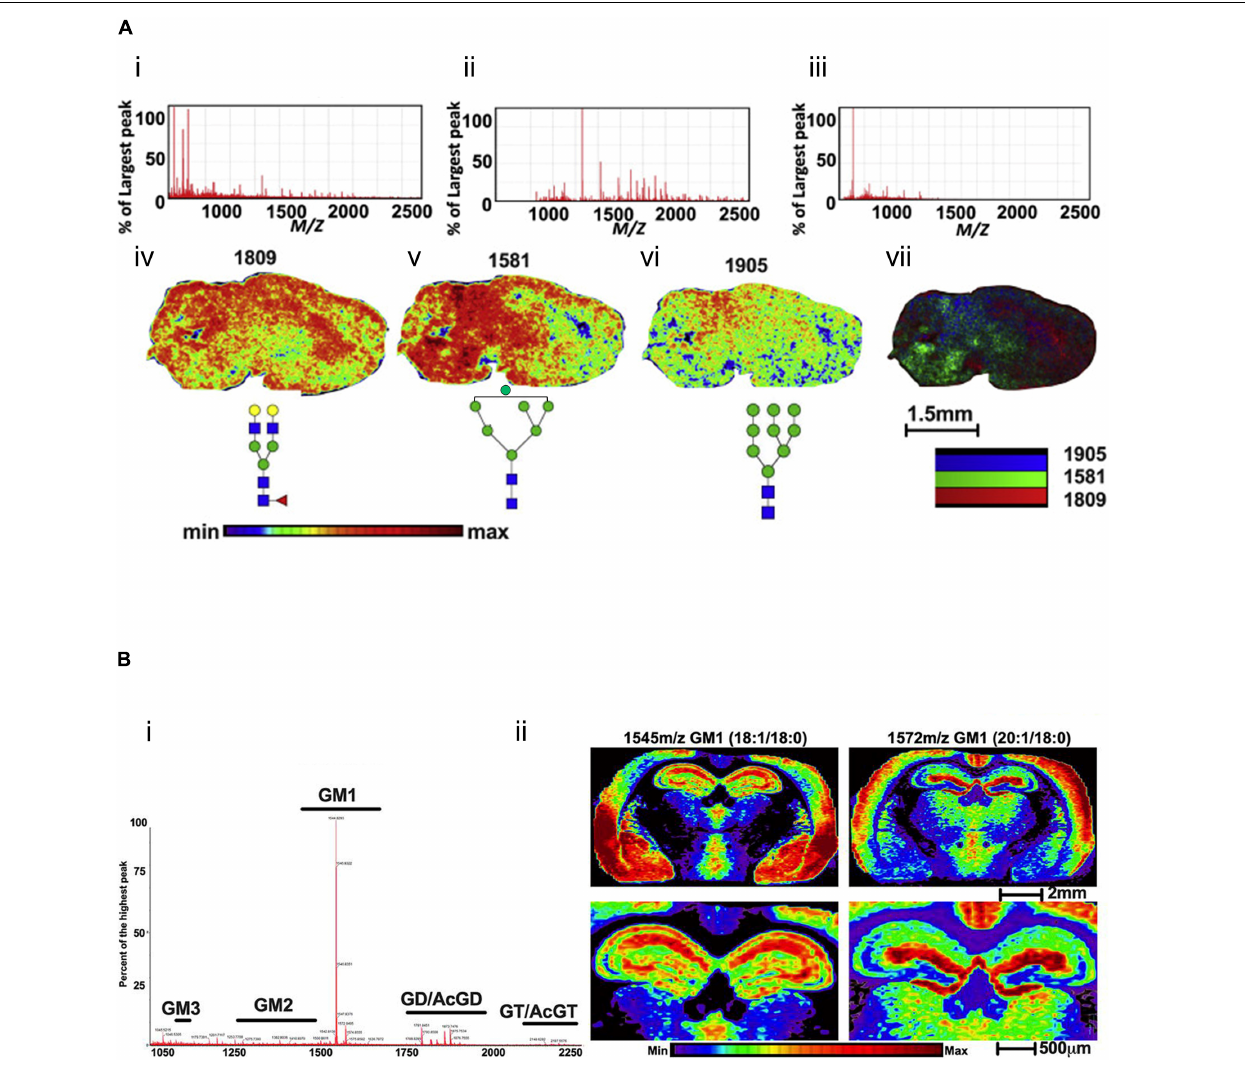
FIGURE 3 | Mass spectra and ion images for glycome in mouse brain tissues. (A) PNGase F digestion and MALDI-MSI analysis of N-glycans in mouse brain tissue. Extracted mass spectra of released N-glycans and matrix ions for (A-i) both, (A-ii) N-glycans and (A-iii) matrix. Representative ion images of (A-iv) Hex5HexNAc4Fuc1 at m/z 1809, (A-v) Hex7HexNAc2 at m/z 1581, (A-vi) Hex9HexNAc2 at m/z 1905, and (A-vii) shows the overlay image of m/z 1809 (red), m/z 1581 (green), and m/z 1905 (blue). Scale bar, 1.5 mm. The mass spectra (B-i) and ion images (B-ii) of gangliosides in the mouse brain coronal section without pre-treatment of the enzyme. Gangliosides are mostly localized in the cortex and hippocampus of the mouse brain tissue section using the CHCA matrix. Scale bar, 2 mm (upper panel), 500 µ m (lower panel). The figures of panels (A,B) are reprinted and modified from Stanback et al. (2021) and Andres et al. (2020), respectively, with free-reuse